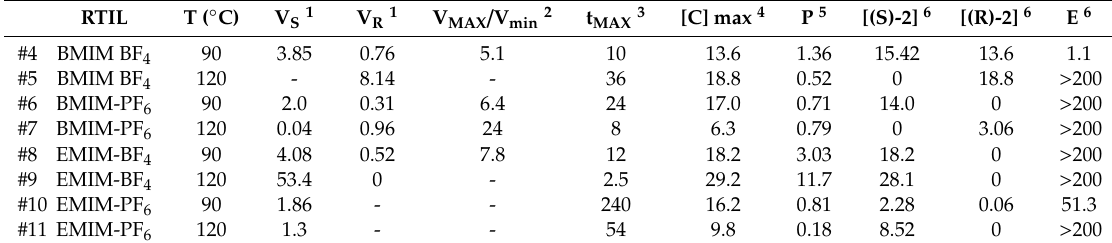
/ VS; 3 higher reaction 1 initial rate (mM / h); 2 VS / V R in all cases except for entries #5 and #7, when it should be V R time (h) at which only one enantiomer is detected; 4 concentration (mM) of the only isomer detected at that higher reaction time; 5 productivity (mM acid / h) at the higher reaction time; 6 enantiomeric ratio, calculated at 12